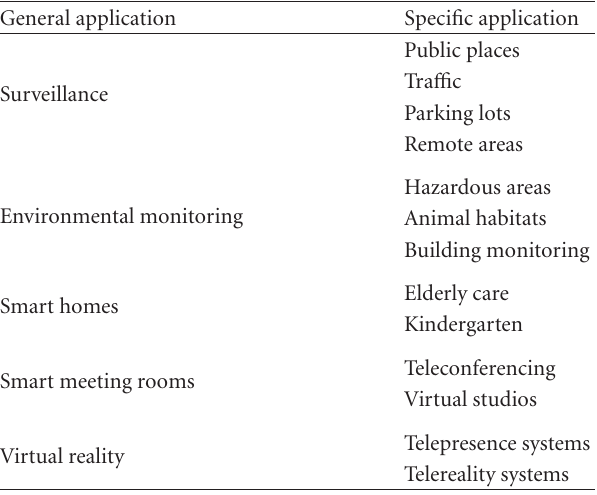
Table 1: Applications of visual sensor